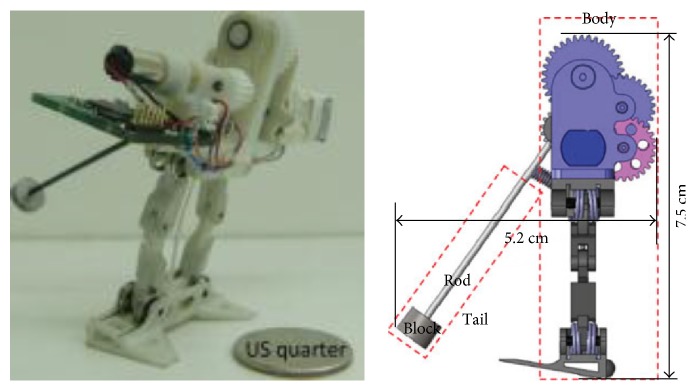
Miniature-tailed jumping robot [74].